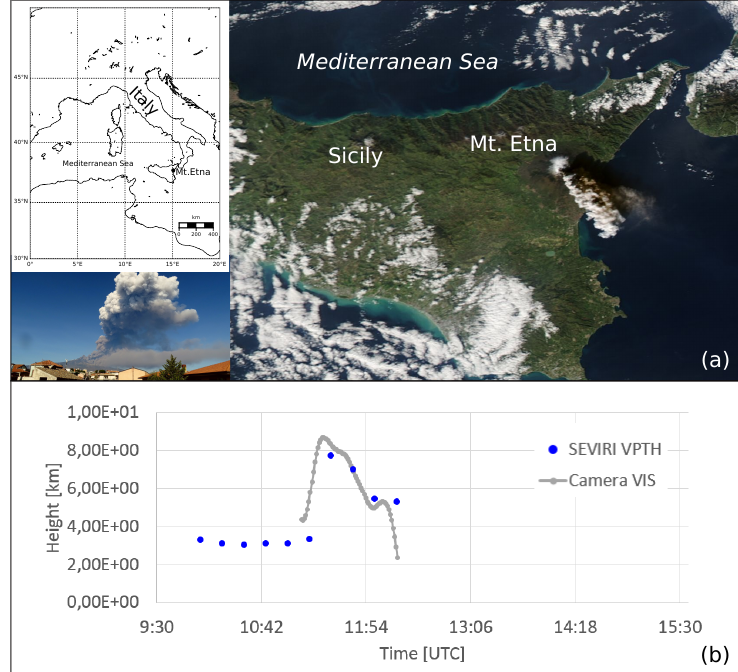
Figure 1. Main box in Panel ( a ) shows the ash plume emitted during the 24 December 2018 eruption as captured by the sensor MODIS on-board Aqua polar satellite. The overpass time is 12:00 UTC which is coincident with the peak in Strombolian activity. The small upper-left box shows the location of Mt. Etna, while a picture taken during the eruption is displayed in the small lower-left box (photo taken by Boris Behncke). Panel ( b ) reports volcanic column height above sea level as estimated by the dark pixel procedure applied to SEVIRI data (blue dots) and by the calibrated VIS camera (gray